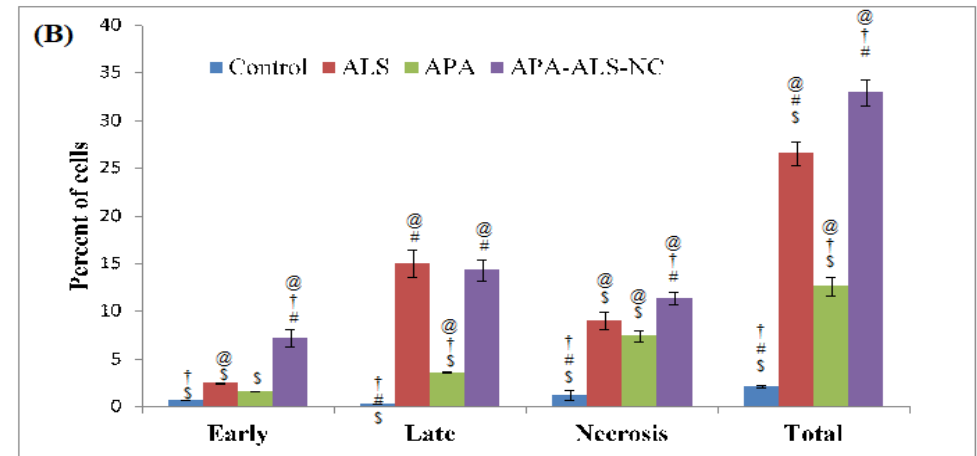
Figure 3. ( A ) Flow cytometry data showing the distribution of cells in control and treated PANC-1 cells. ( B ) Bar graphs represent apoptotic activity of control, ALS, APA, and APA-ALS-NC samples on PANC-1 cells. (Statistical inferences: @ p < 0.05, in comparison to control; † p < 0.05, in comparison to ALS; # p < 0.05, in comparison to APA; and $ p < 0.05, in comparison to APA-ALS-NC).